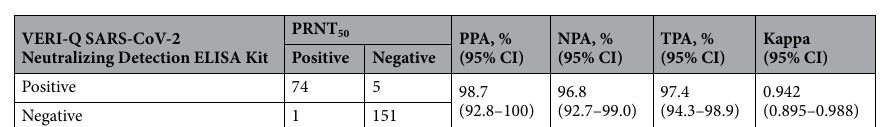
Table 1. Diagnostic accuracy of VERI-Q SARS-CoV-2 Neutralizing Detection ELISA Kit for the detection of neutralizing antibodies against SARS-CoV-2 compared to the 50% plaque reduction neutralization test. PPA positive percent agreement; NPA negative percent agreement; TPA total percent agreement; PRNT plaque reduction neutralization test.